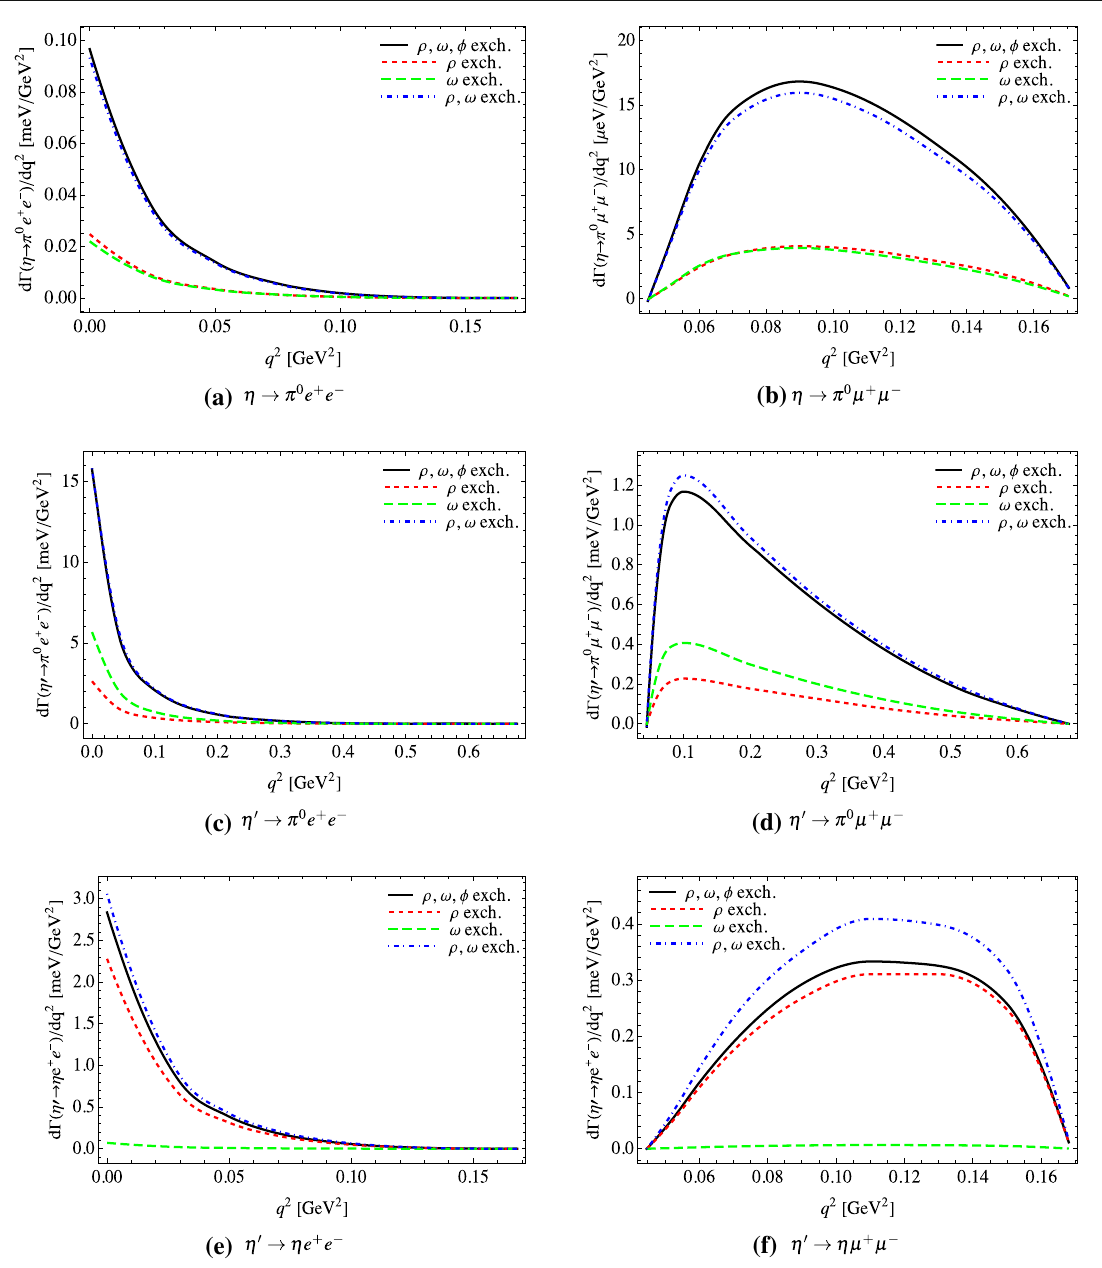
Fig. 1 Dilepton energy spectra corresponding to the six C -conserving semileptonic decay processes η ( (cid:2) ) → π 0 l + l − and η (cid:2) → η l + l − ( l = e or μ ) as a function of the dilepton invariant mass q